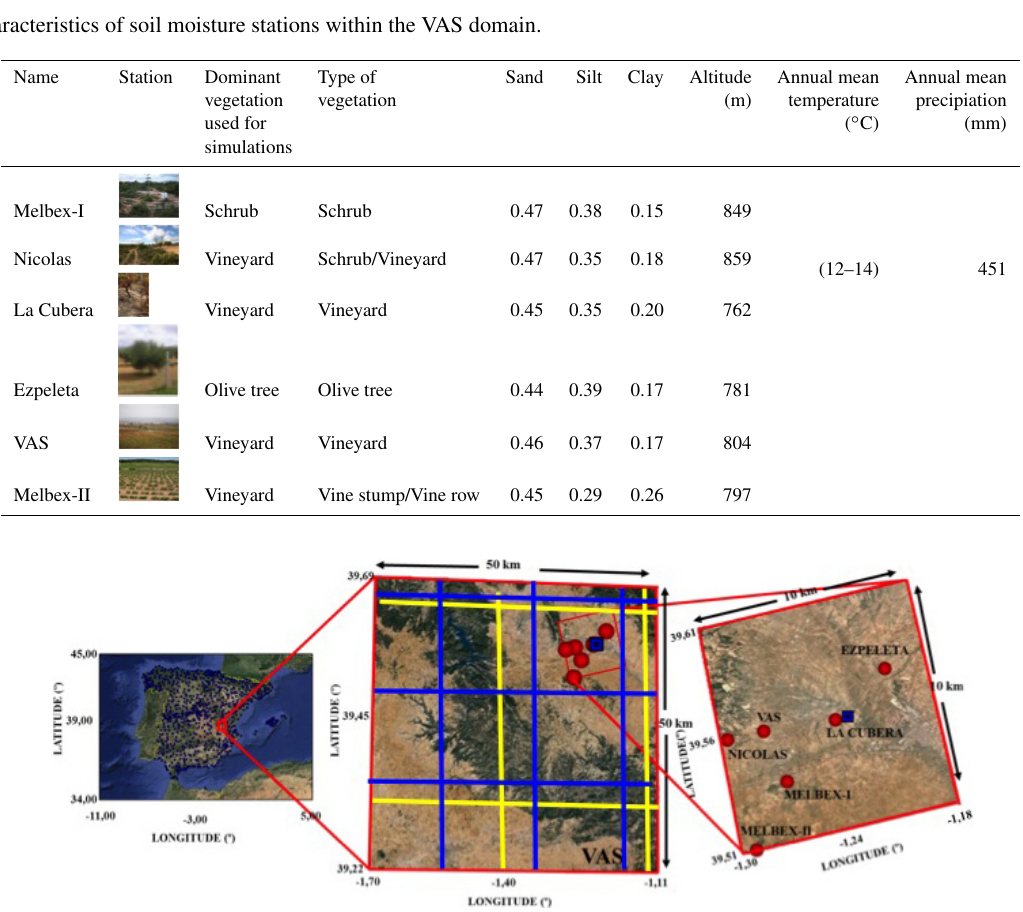
Figure 1. Area of investigation and orography. Location of rain gauges from AEMET (Spanish State Meteorological Agency) is shown over the Iberian Peninsula (blue squares). The positions of the soil moisture network stations within the 10km × 10km (OBS area) in the VAS (50km × 50km) area are indicated by red